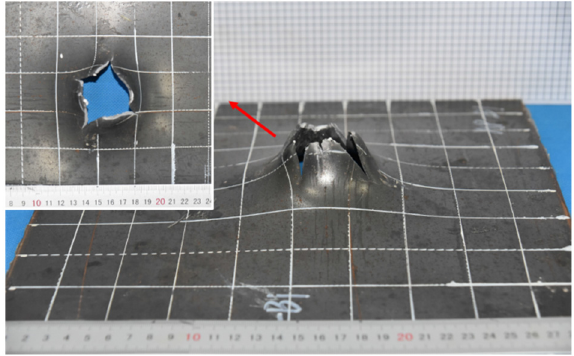
Figure 16. Fracture morphology of back plate in Experiment 1.